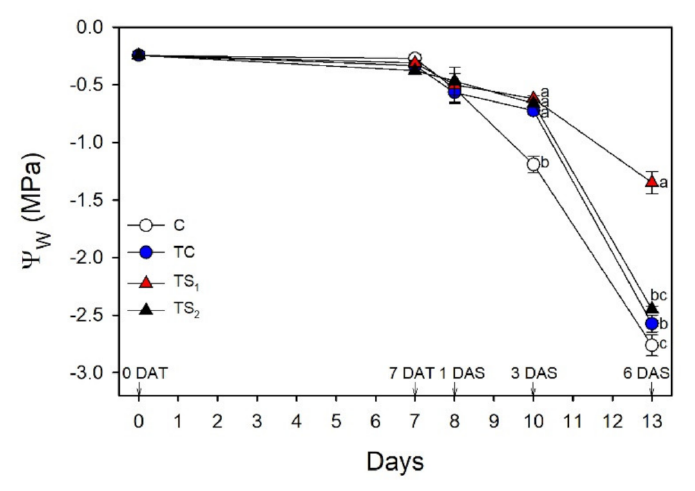
Figure 2. Leaf water potential ( ψ w ) in purple basil cv. Red Rubin at 0 and 7 days after bacterial treatment (0 DAT and 7 DAT, respectively) and at 1, 3 and 6 days after water stress (1 DAS, 3 DAS and 6 DAS, respectively). Values are means ± SE ( n = 6). Different letters indicate significant differences among bacterial treatments and control (one-way ANOVA with Fisher’s LSD test, p ≤ 0.05).